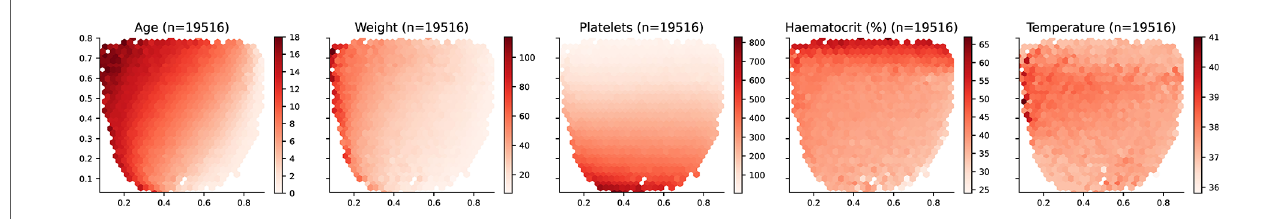
FIGURE 4 Latent space description: Features. The graphs represent the density distribution using hexagonal binning over the latent space for the fi ve features selected to train the Autoencoder. The title includes the name and the number of daily pro fi les. The value on each hexagonal bin represents the mean value of all the daily pro fi les that have been projected on that bin. A detailed set of graphs describing other laboratory results has been included in Figure A1 (Appendix) .